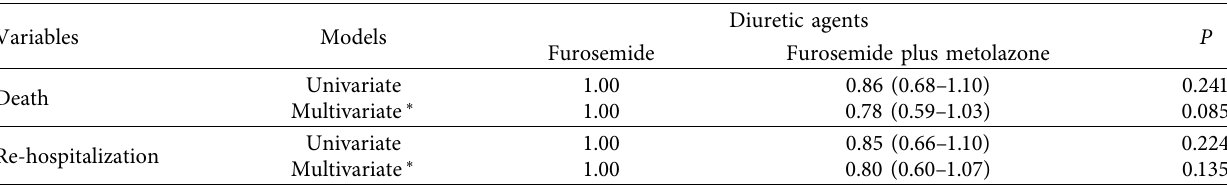
Table 3: Hazard ratio and odds ratio of death and re-hospitalization among study population according to different categories of diuretic usages.